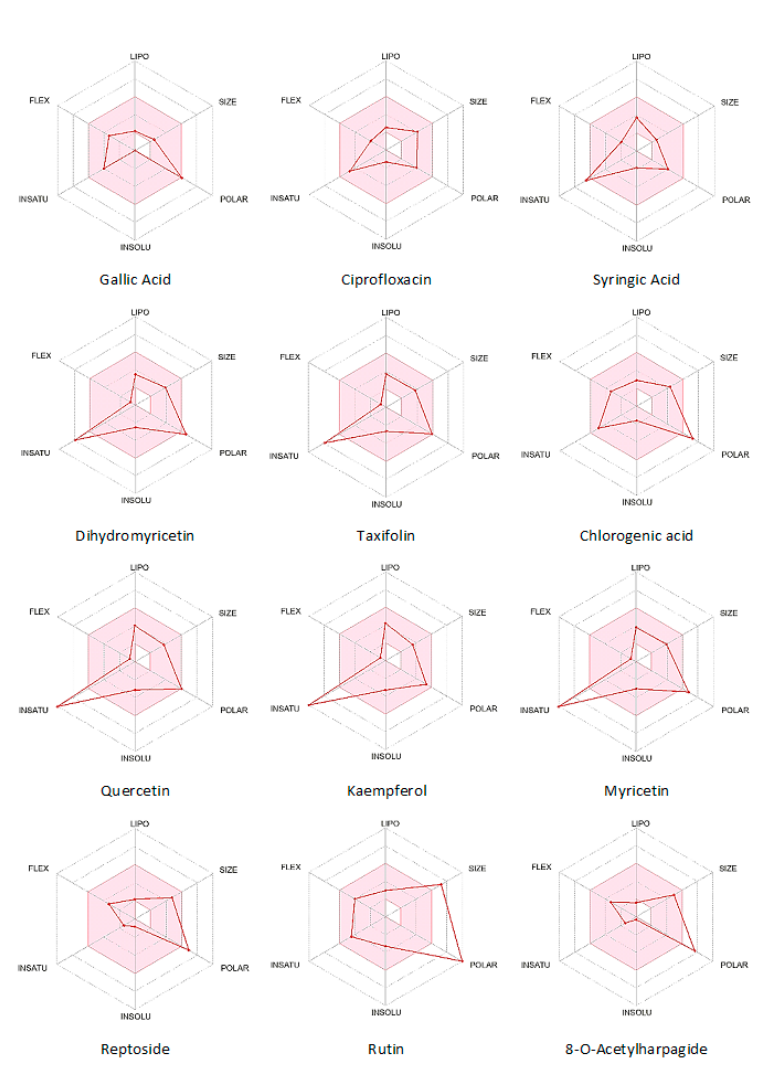
Figure 3. Bioavailability radar for the ligand molecules from SwissADME.